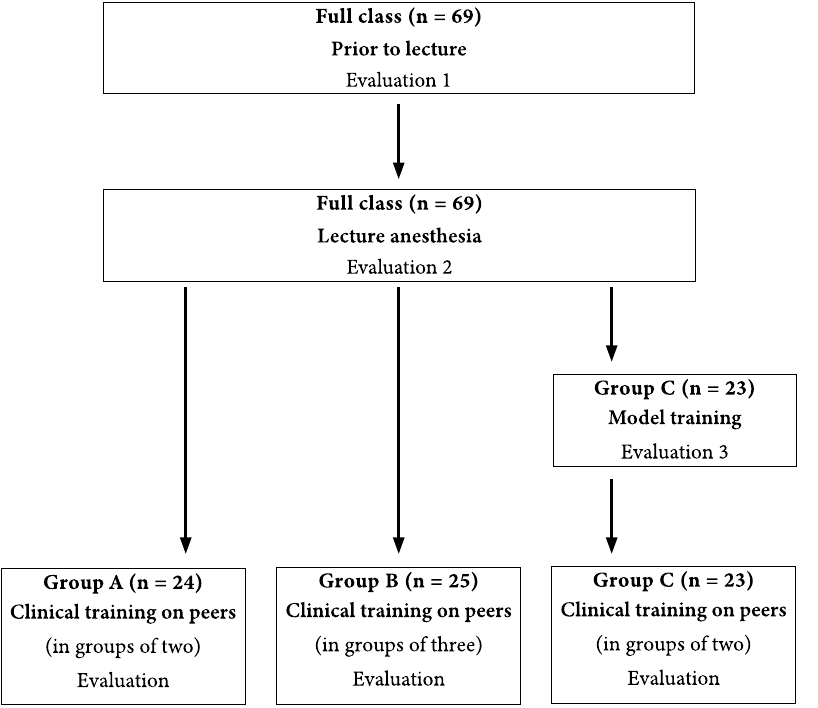
Figure 1. Study design for evaluation of students’ self confidence in using local anesthesia during